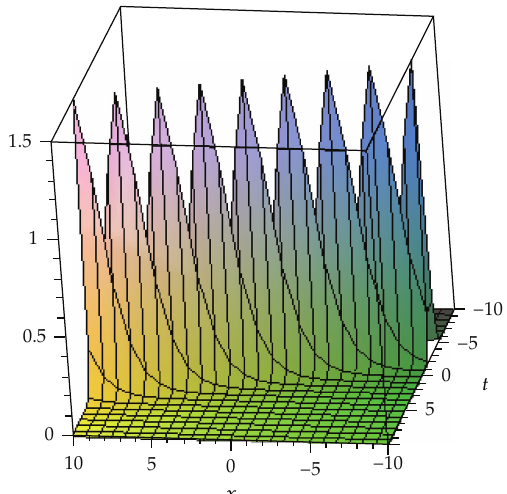
Figure 4: Solitons solution for y (cid:8) 0 and z (cid:8) 0.